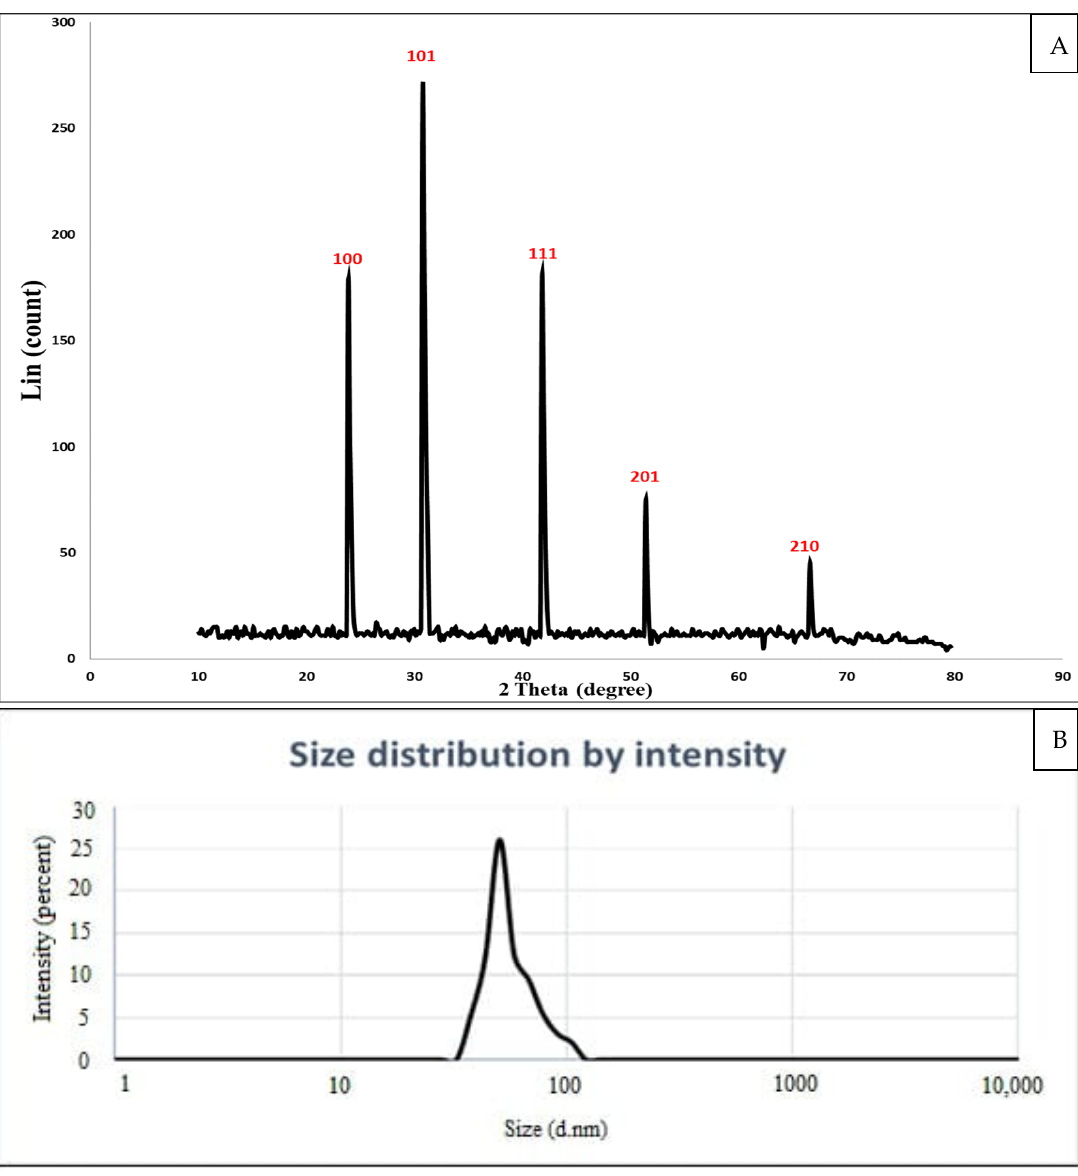
Figure 4. XRD analysis showed the crystalline nature ( A ); DLS analysis of mycosynthesized SeNPs ( B ).